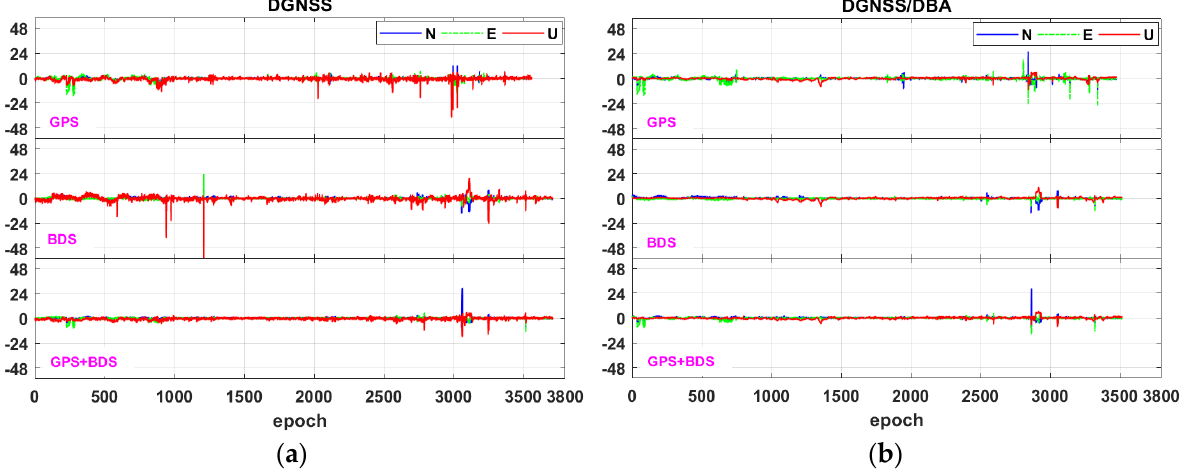
Figure 20. The deviation sequence of geodetic Trimble Net R9 receiver in the N/E/U directions during the kinematic vehicle experiment in the complex urban environment: ( a ) DGNSS positioning mode; ( b ) DGNSS/DBA positioning mode.